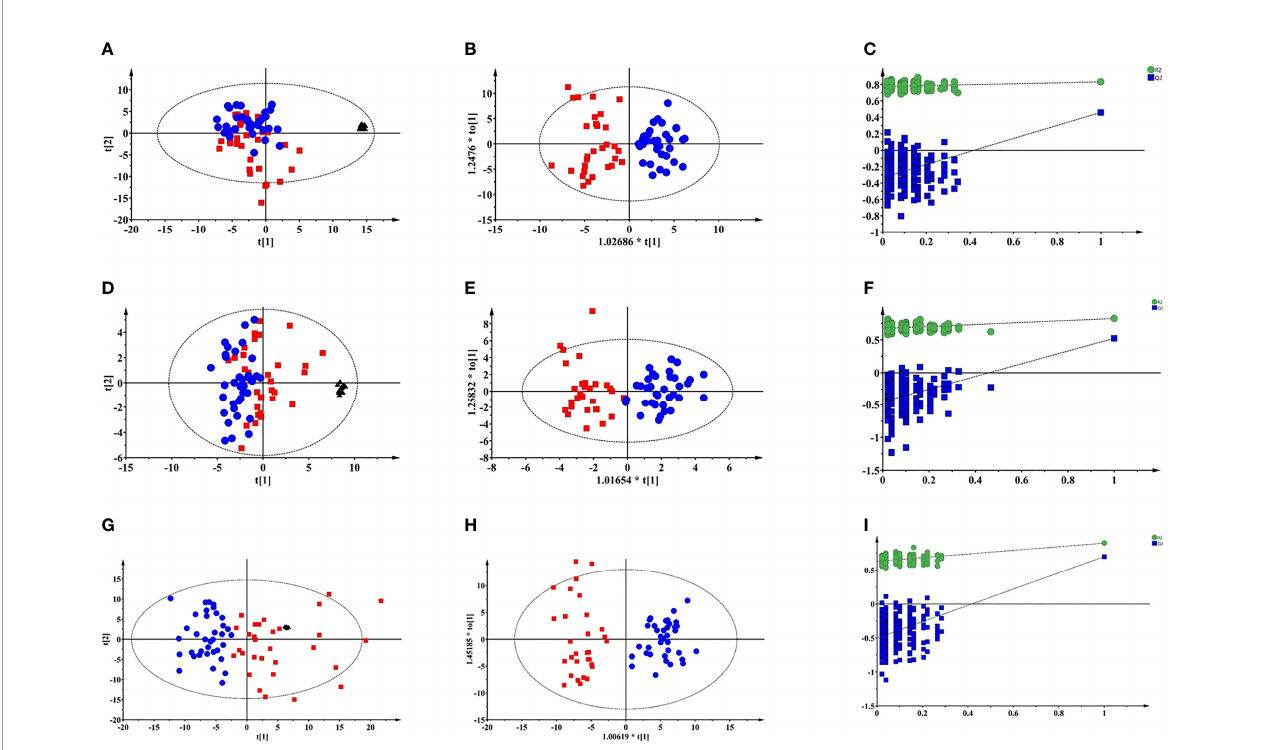
FIGURE 1 | Multivariate modelling of LC-MS and GC-MS data after log transformation and pareto scaling. (A) PCA score plot of LC-MS (+) data: R 2 X=0.527, Q 2 = 0.322; (B) OPLS-DA score plot of LC-MS (+) data: R 2 X=0.131, R 2 Y=0.782, Q 2 = 0.502, CV-ANOVA p value = 1.0e -10 ; (C) the 200-permutation test of LC-MS (+) data; (D) PCA score plot of LC-MS (-) data: R 2 X=0.613, Q 2 = 0.255; (E) OPLS-DA score plot of LC-MS (-) data: R 2 X=0.165, R 2 Y=0.816, Q 2 = 0.535, CV-ANOVA p value =2.4 e -9 ; (F) the 200-permutation test of LC-MS (-) data; (G) PCA score plot of GC-MS data: R 2 X=0.681, Q 2 = 0.458; (H) OPLS-DA score plot of GC-MS